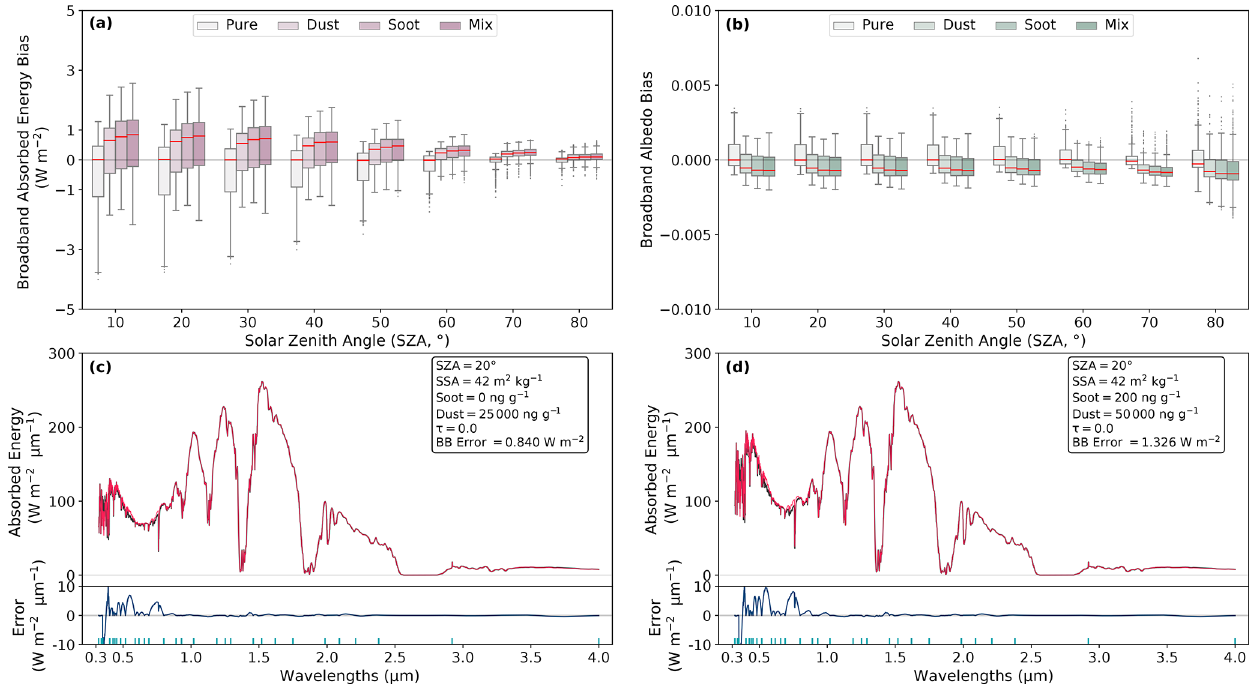
Figure 5. Bias on the broadband absorbed energy (a) and on the broadband albedo (b) as a function of the SZA and the LAP content. The biases are calculated for all the simulations described in Sect. 2.5.3 and 2.5.4 between the absorbed energy calculated by the method and the reference absorbed energy calculated by TARTES–SBDART. The red lines indicate the median, the box shows the 25th to 75th percentiles, and the whiskers show the 5th to 95th percentiles. Example of absorbed energy profiles for a snowpack with LAPs as a function of wavelength calculated for an SZA of 30 ◦ for a snowpack which contains dust (c) and a mix of soot and dust (d) . The black lines represent the absorbed energy calculated by TARTES–SBDART at 1nm resolution, and the red lines represent the absorbed energy calculated by VALHALLA. In blue, the errors on the absorbed energy for these same simulations are shown as a function of wavelength. The green vertical lines represent the TPs used in